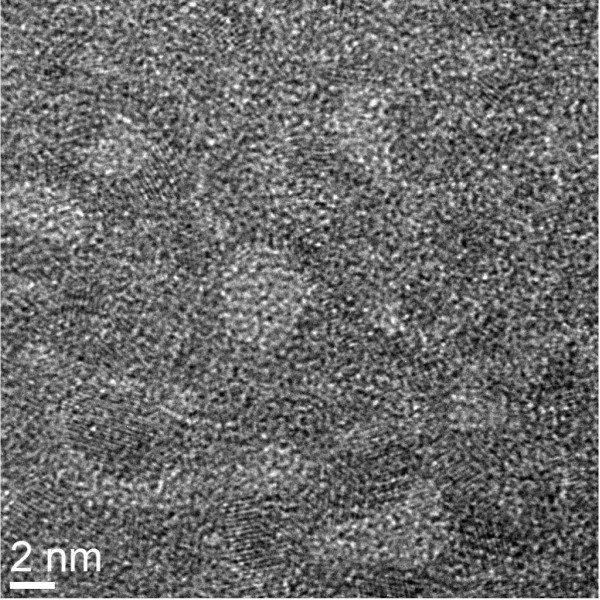
Plan-view TEM image of an IrOx layer. With a typical thickness of approximately 3 nm on the SiO2/Si substrate. The IrOx metal is black and SiO2 is white. The IrOx metal layer contains pores that oxygen can readily migrate through.